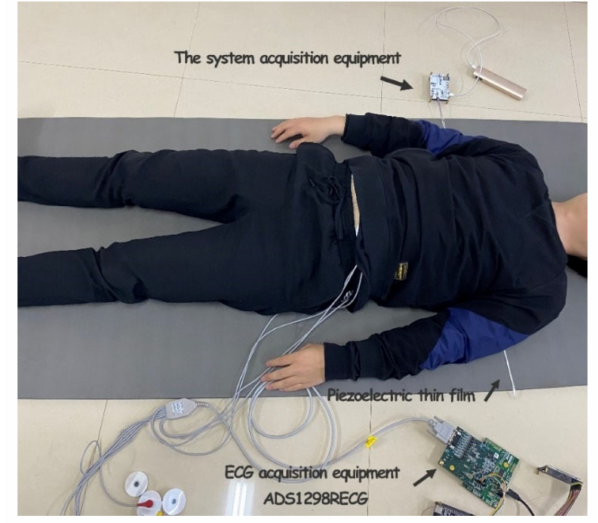
Figure 5. Acquisition system physical